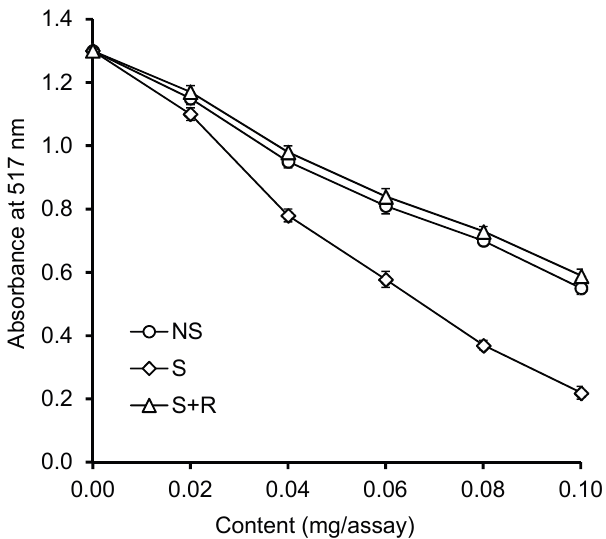
Figure 4. Antiradical activity of the grape seed extracts against 2,2'-diphenyl-1-picrylhydrazyl (DPPH) free